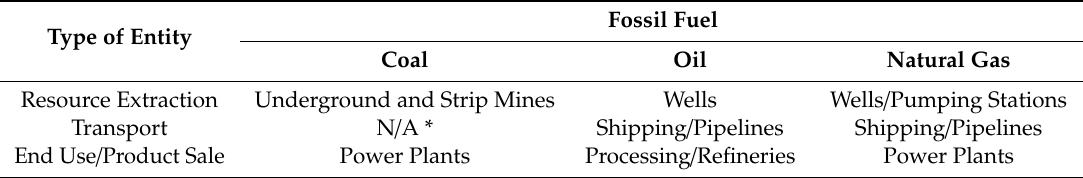
Figure 3. Equation used to calculate potential annual CO 2 emissions (MT CO 2 e) of a natural gas facility.